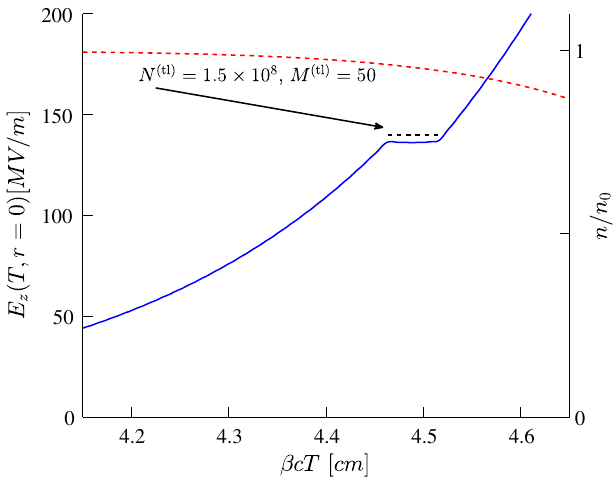
FIG. 13. Wake dynamics (solid curve) for resonance mode number of s 0 ¼ 360 in the length interval of 4 . 15 cm ≤ β cT ≤ 4 . 65 cm. The second trailing train bunch (dash-dotted curve) is located at the quasilinear regime, where the normalized PID (dashed curve), n=n 0 , is nearly constant and approximately equals to